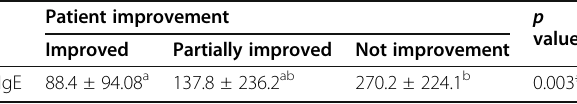
Table 3 IgE level among studied patient according to patients ’